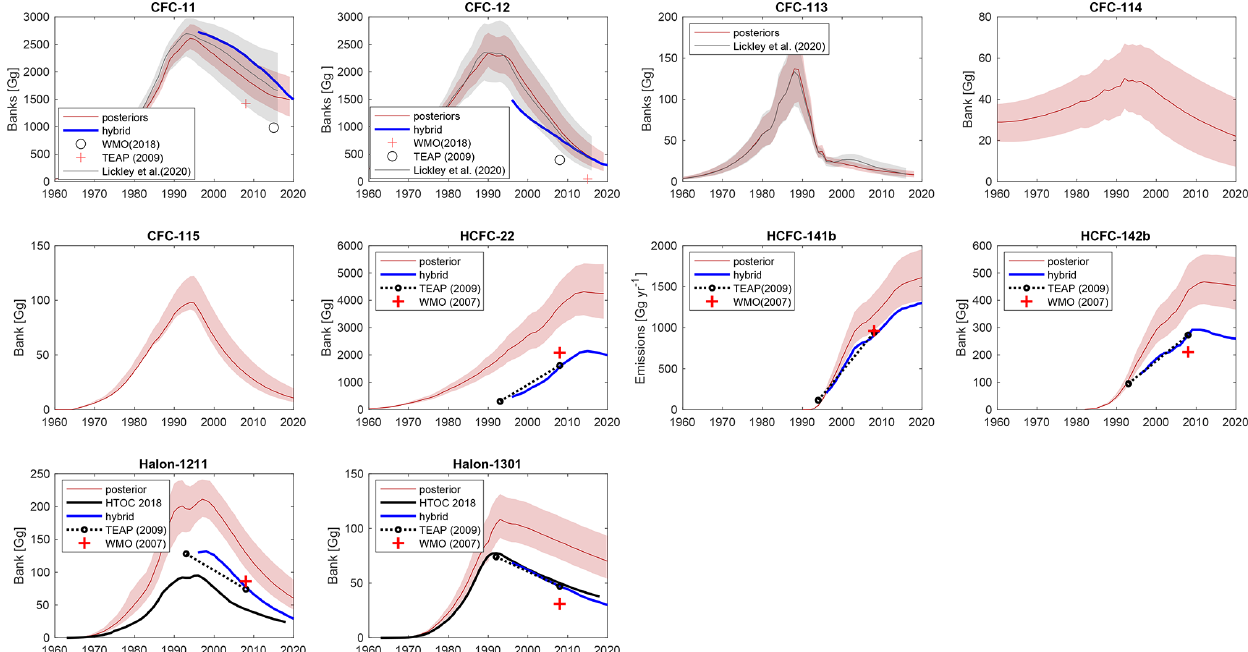
Figure 3. Magnitudes of bank estimates. The red lines indicate the median posterior estimate of banks from the Bayesian analysis, with shading indicating the 90% confidence interval. Previously published bank estimates are provided for comparison from the 2009 TEAP report (Kuijpers and Verdonik, 2009), WMO (2007), WMO (2018) and Lickley et al. (2020) along with the hybrid approach updated to current estimated starting values. Table 2. Estimated bias in cumulative reported production. Values indicate the percent difference between inferred cumulative production from the onset of production to 2019 relative to reported production, for all uses except feedstock production. Positive values indicate the percent by which inferred production is higher than